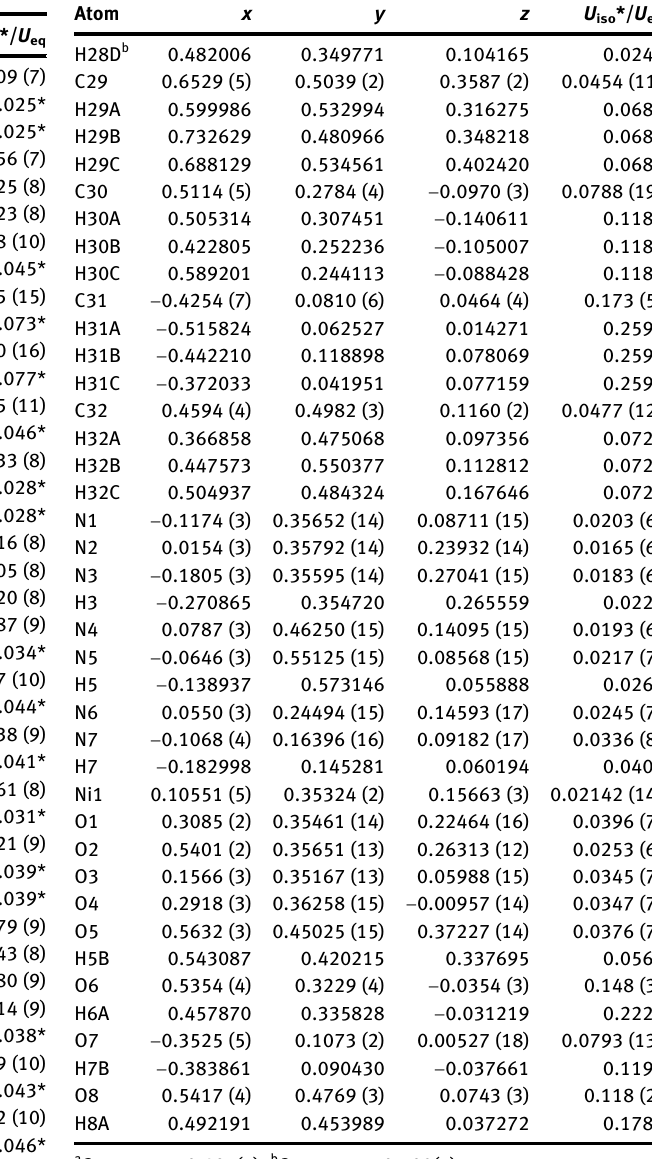
Table  : Fractional atomic coordinates and isotropic or equivalent isotropic displacement parameters (Å 